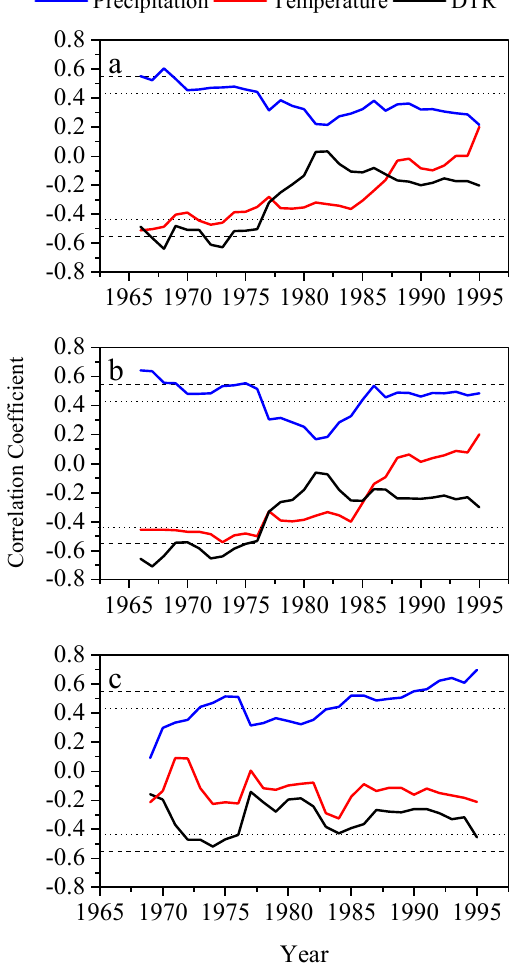
Figure 9. 21–year running correlations between the ( a ) TRW chronology and the mean precipitation (May − September of the current year), temperature (June − September of the current year) and DTR (June − October of the current year); the ( b ) LWW chronology and the mean precipitation (May − Oc- tober of the current year), temperature (June − September of the current year) and DTR (June − October of the current year); the ( c ) LWR chronology and the mean precipitation (July − October of the current year), temperature (July − October of the current year) and DTR (June − September of the current year). Dotted and dashed horizontal lines indicate the p = 0.05 and p = 0.01 significance levels, respectively.